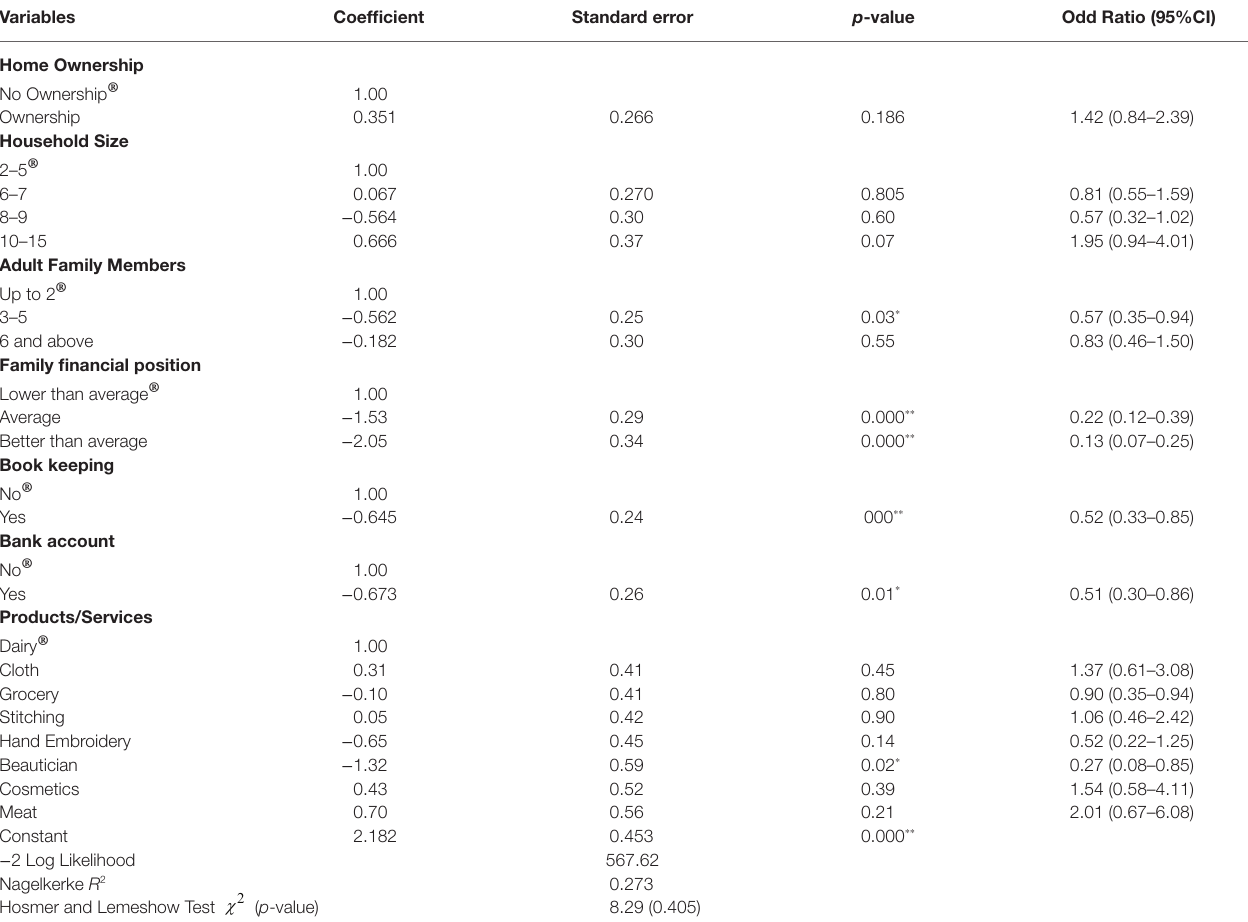
TABLE 3 | Binary logistic regression